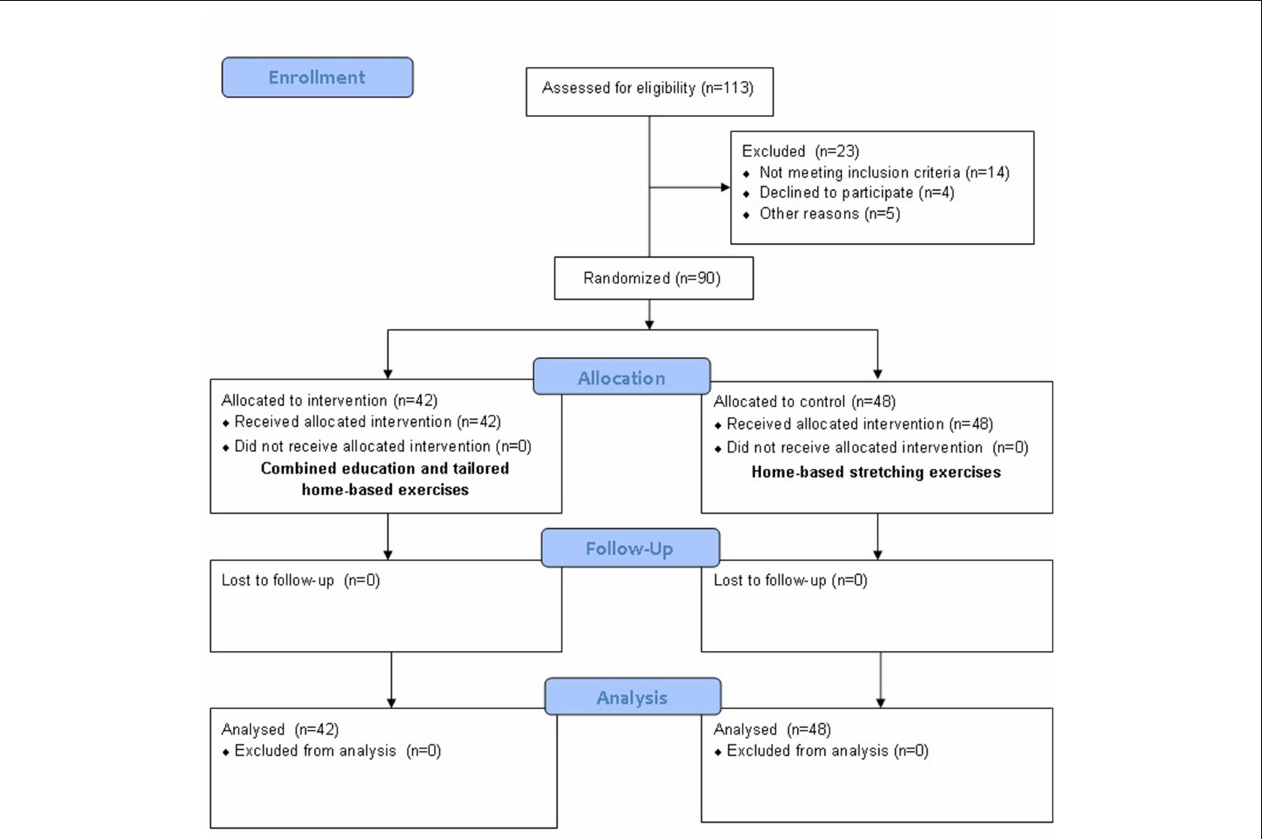
FIGURE 1 | CONSORT flow